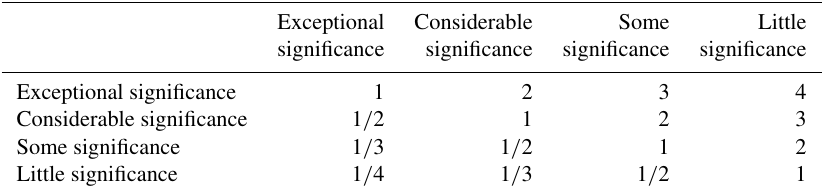
Table A7. Judgement matrix adopted for the calibration of the CH value